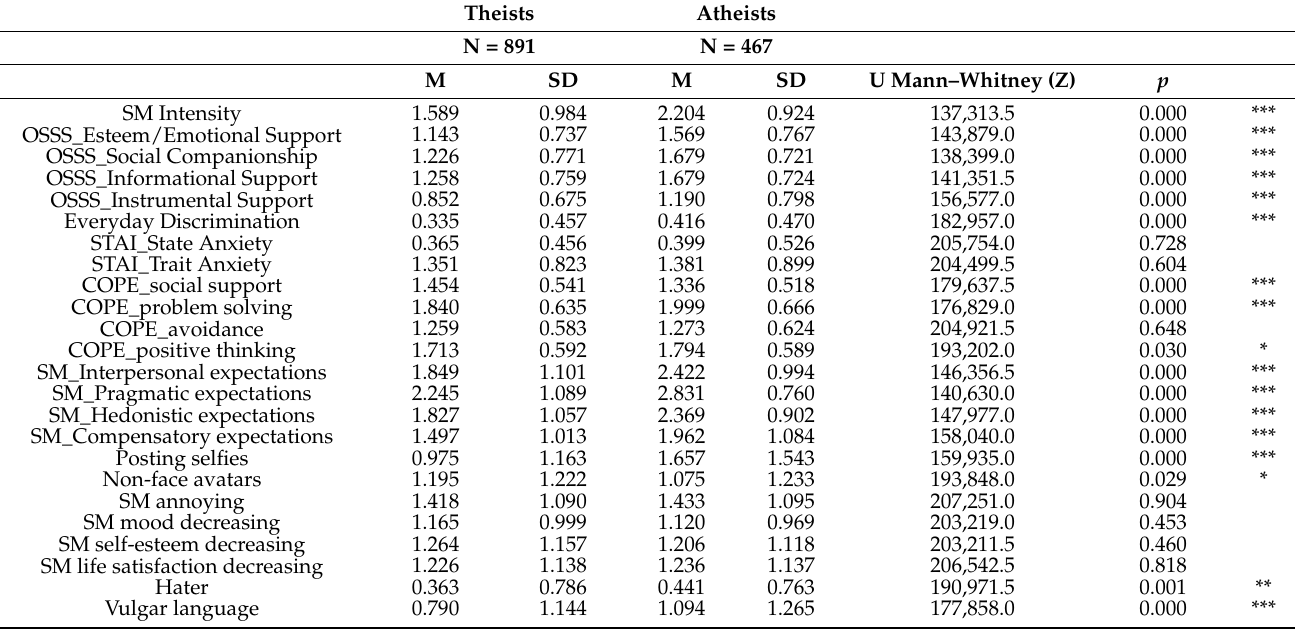
Table 1. Comparison of study variables between theists and